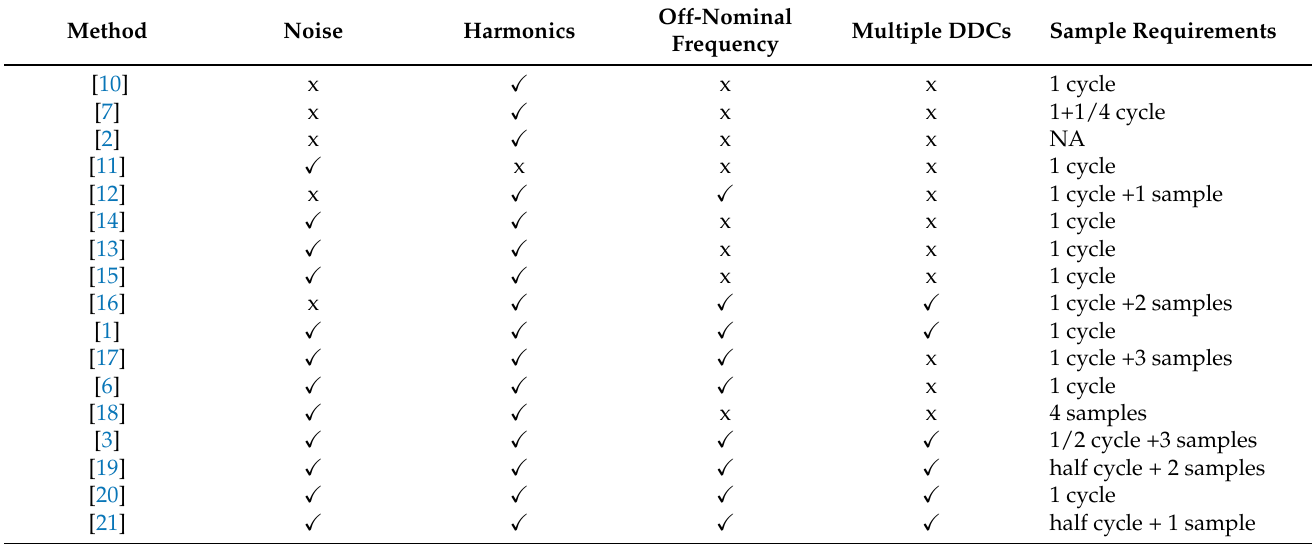
Table 2. Pre-DFT DDC mitigation methods comparative analysis in the presence of destructive factors.